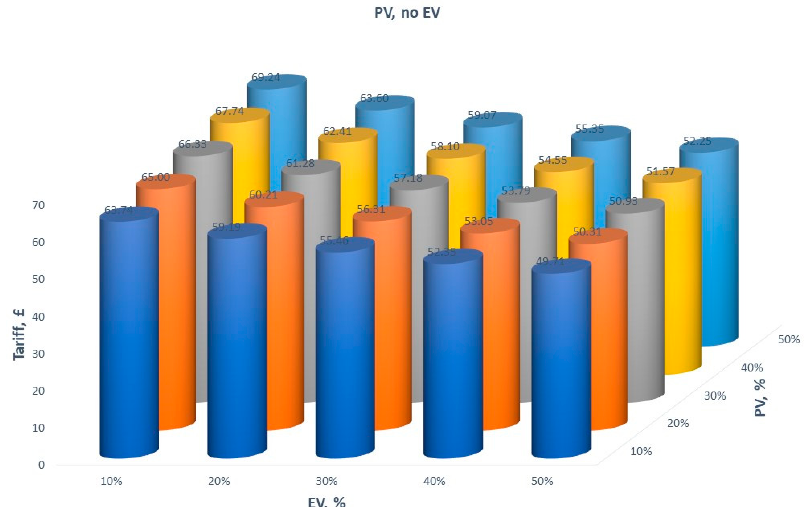
Figure 1. Distribution tariffs for households with no EV and no PV. Source: Own results.